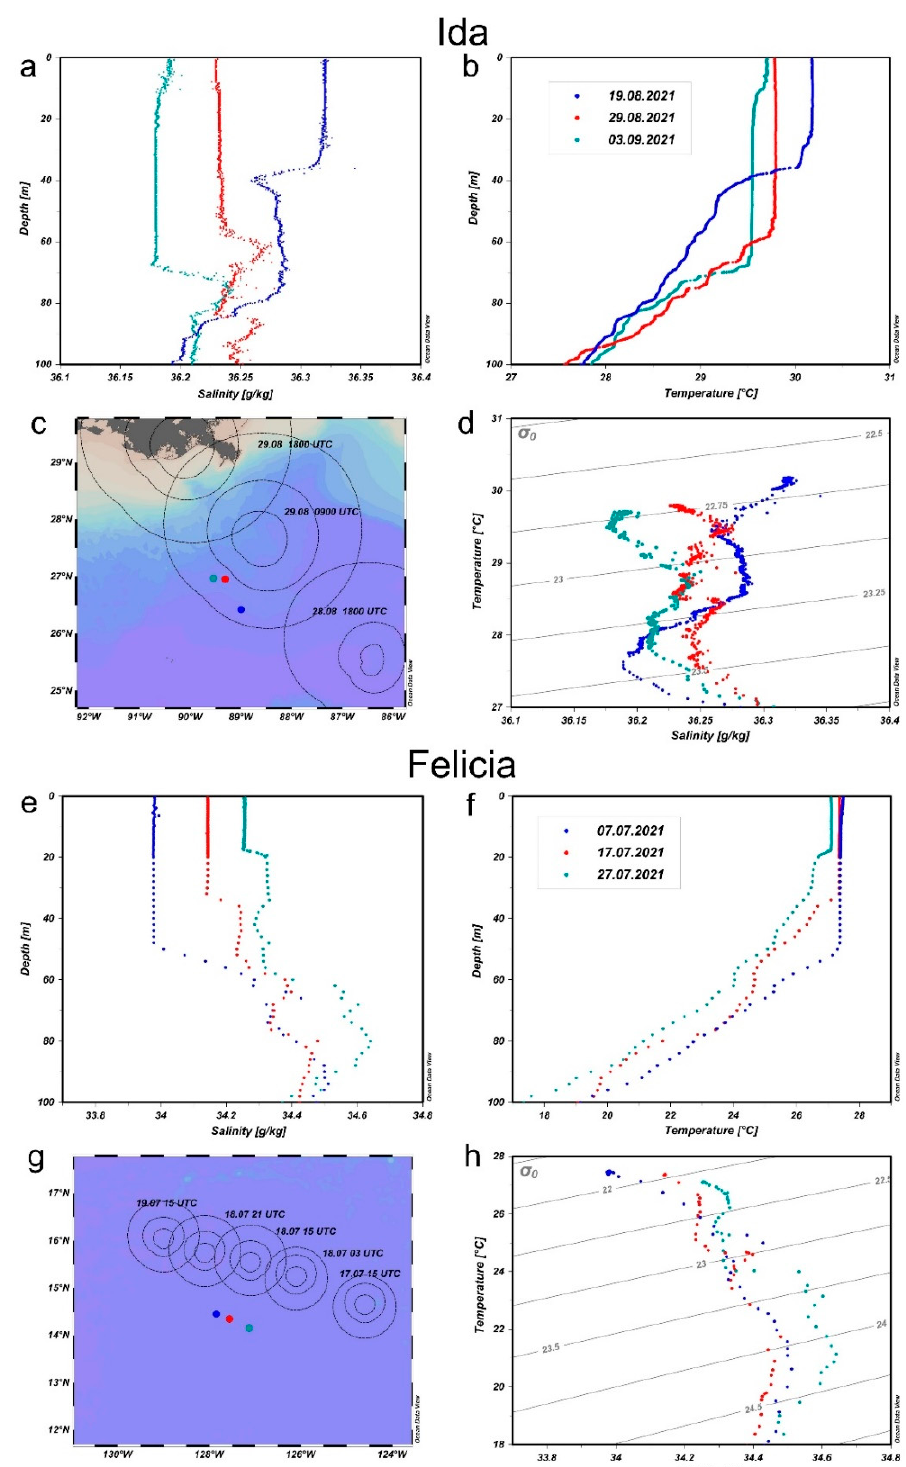
Figure 4. Argo-derived vertical profiles from the Gulf of Mexico for TC Ida ( a – d ) and from the eastern North Pacific for TC Felicia ( e – h ). Shown are salinity ( a , e ) and temperature ( b , f ) depth profiles, TS diagrams ( d , h ), and the location of the Argo-floats ( c , g ), as well as the initial wind radii, which show the maximum extent of the 34 kt, 50 kt, and 64 kt winds in each quadrant of the storm. The date of the measurements is indicated by different colors. Argo numbers are 4903554 for Ida and 5906400 for Felicia. All graphs were plotted with R version 4.1.2 [35] using the “ggplot2” package [36], except for the Argo profiles, which were made with ODV [34]. Anomaly maps for SST and